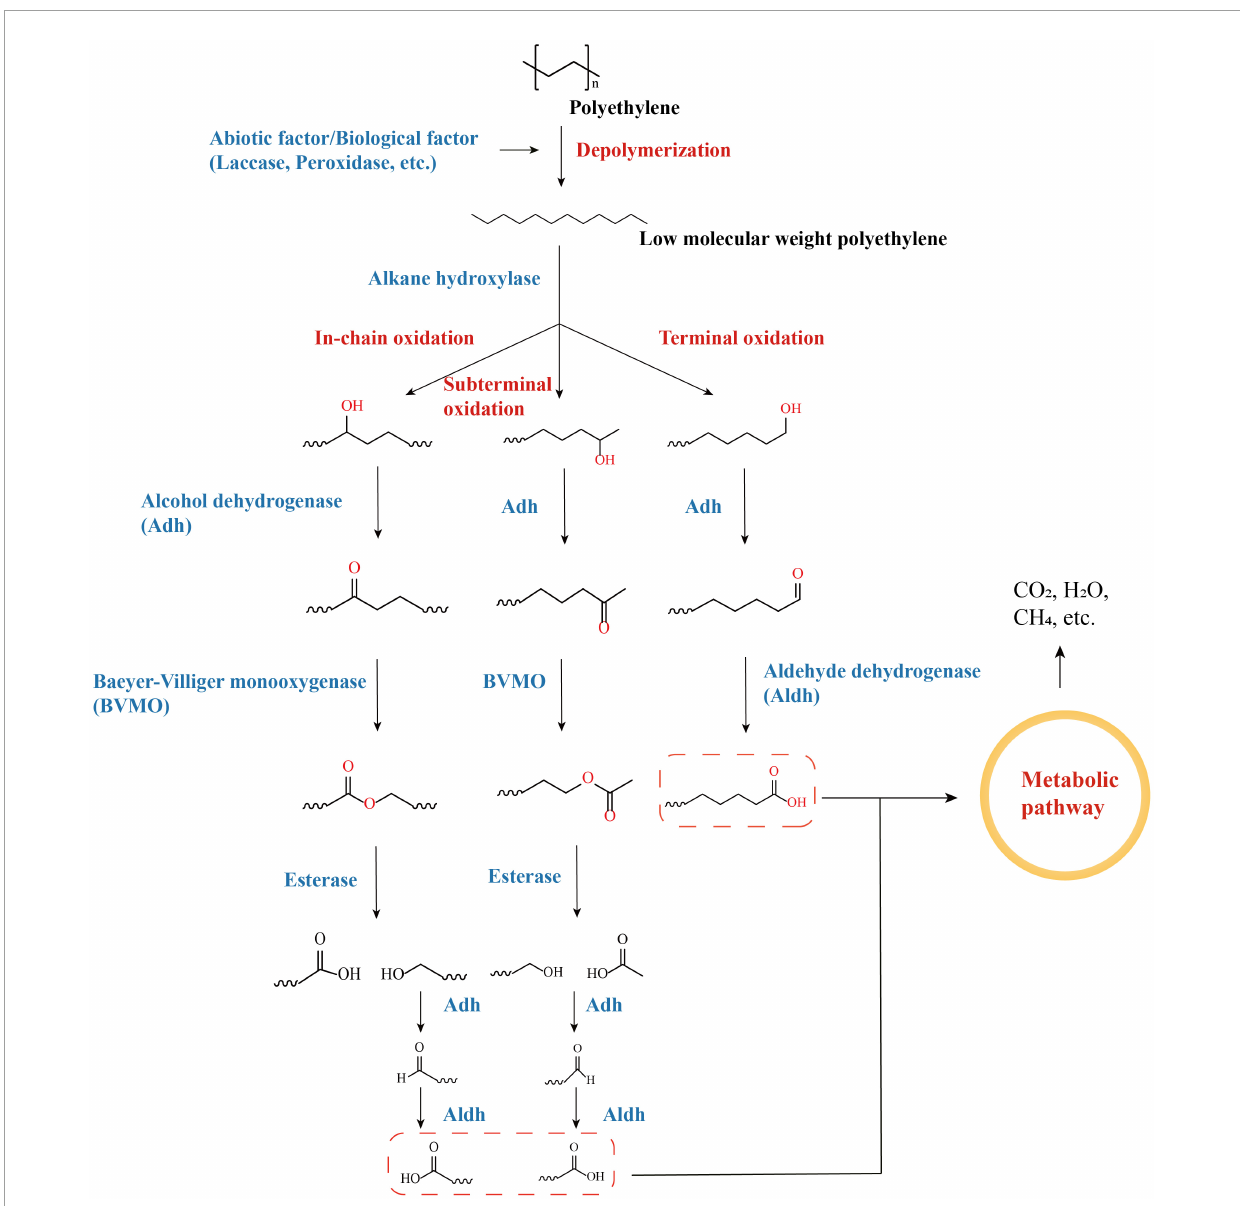
FIGURE3 Degradation pathways of PE-derived long-chain linear alkanes by oxidation with alkane hydroxylases (AHs).